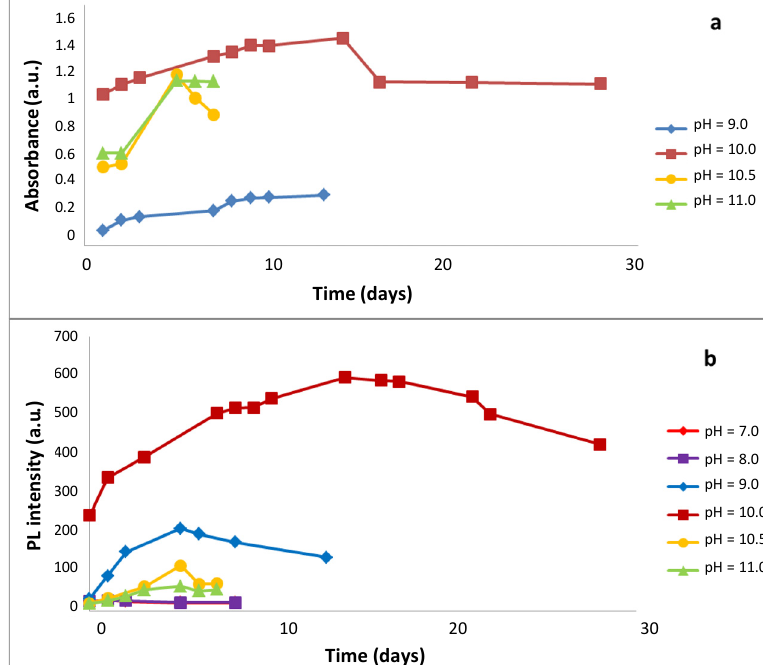
Figure 3. Influence of the change in pH during synthesis. ( a ) Evolution of the maximum absorbance values at different times for different pH values. ( b ) Temporal evolution of the Photoluminescence intensity at different pH values. Under operating conditions the final concentration and their molar ratios were as follows: [Cd 2+ ] F = 7.477 × 10 − 4 mol/L; [BSA] F = 3.738 × 10 − 4 mol/L; [thioacetamide] F = 3.738 × 10 − 4 mol/L; [Cd 2+ ] F /[thioacetamide] F = 2.0; [Cd 2+ ] F /[BSA] F = 2.0, Room temperature.